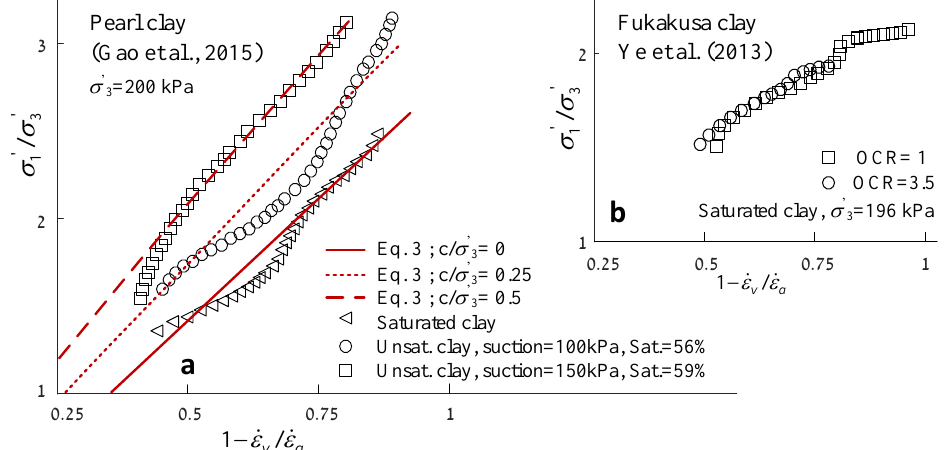
Figure 7. Stress-dilatancy representation of drained triaxial test results of ( a ) unsaturated clays in different applied suctions and water saturations, and ( b ) saturated clays in different overconsilidation ratios. Modified from Gao et al. [45] and Ye et al. [44],